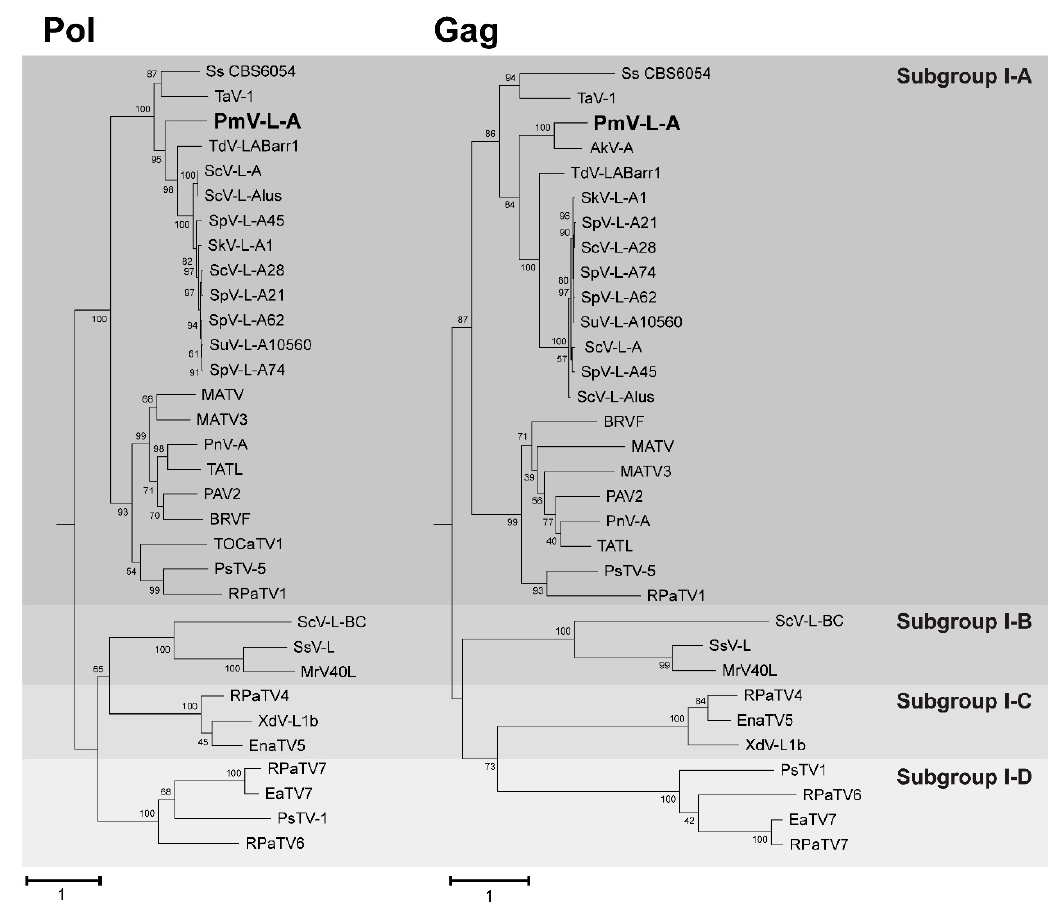
Figure 3. Phylogenetic analysis of the Gag and Pol proteins encoded by PmV-L-A. Rooted maximum likelihood phylogenic models were constructed using PhyML with Pol ( left ) and Gag ( right ) proteins from PmV-L-A (bold) and related totiviruses. The LG model with a gamma distribution (G) and invariable sites (I) was the substitution matrix that best fits these datasets. The numbers at each node are the bootstrap values from 1000 iterations. The scale bar represents the distance of one amino acid substitution per site. The amino acid sequences in the phylogeny are from the viruses listed in Table S1.